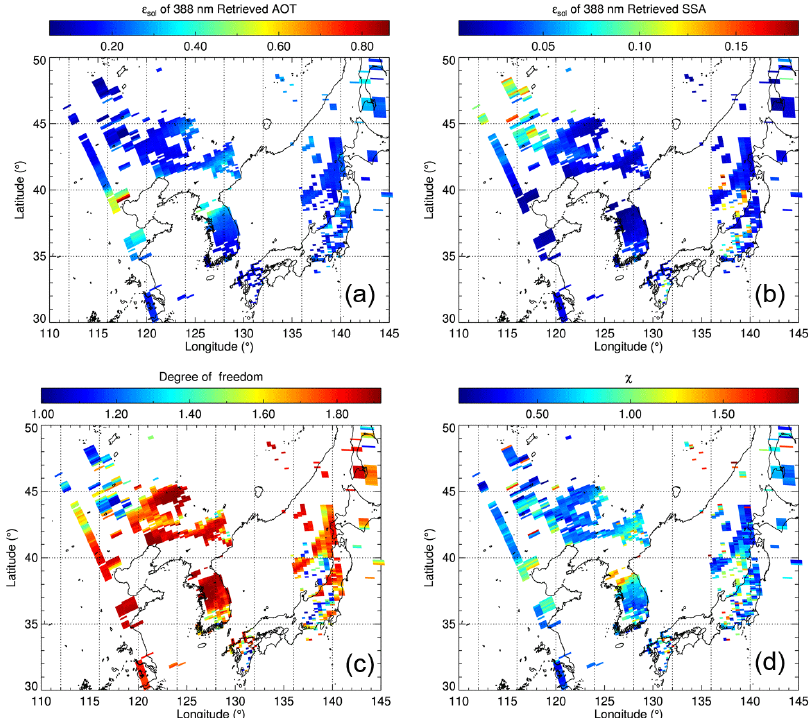
Figure 5. Estimated solution error of (a) OE-based 388nm AOT and (b) SSA. Panels (c) and (d) show the degrees of freedom and cost function of the retrieval,